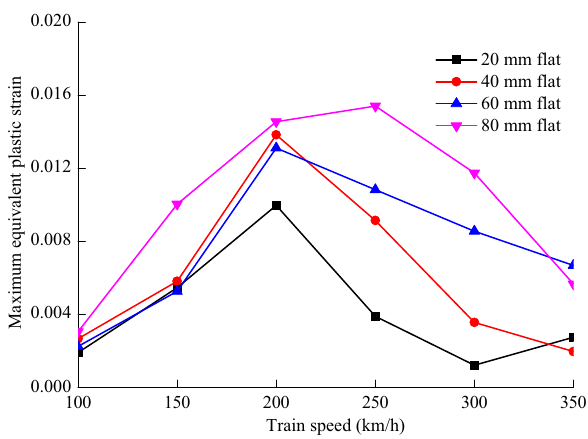
Fig. 8 Maximum equivalent plastic strain as a function of train speed